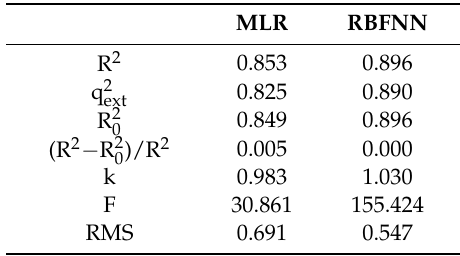
Table 4. The statistical results of the external test set for the MLR and radial basis function neural network (RBFNN) models.